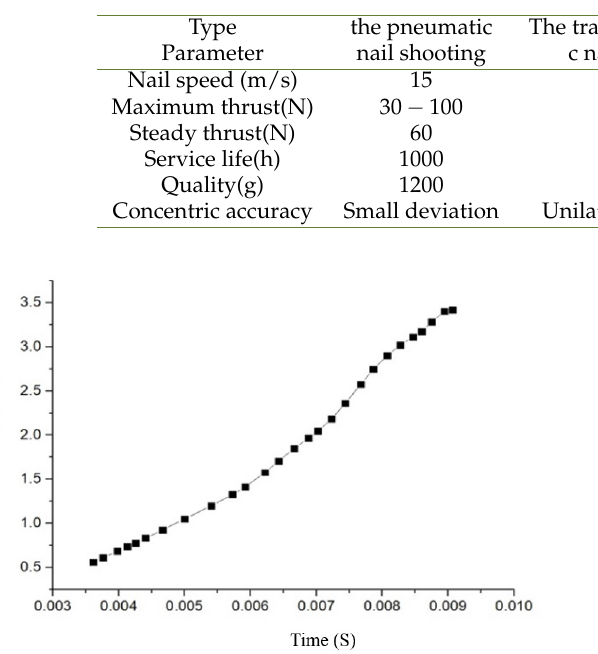
Table 3. Parameters comparison of nail shooting device.